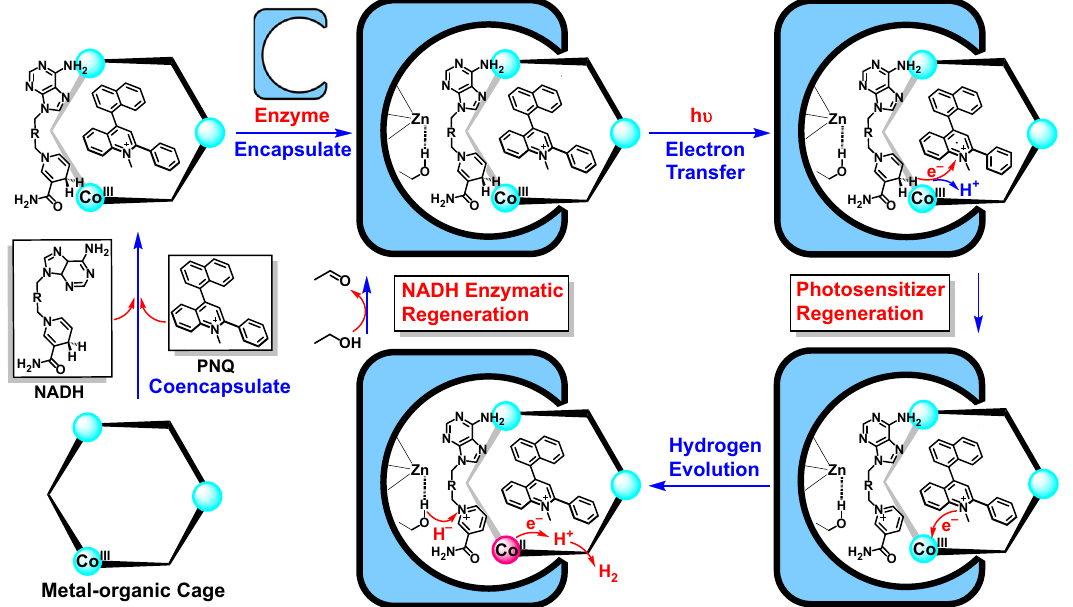
Fig. 6 Proposed mechanisms for abiotic – biotic coupled system in photocatalytic alcohol splitting. Schematic of semibiological supramolecular system for solar alcohol splitting showed that the coenzyme locked in the ADH catalytic pocket joined arti fi cial photocatalysis with enzymatic reactions in